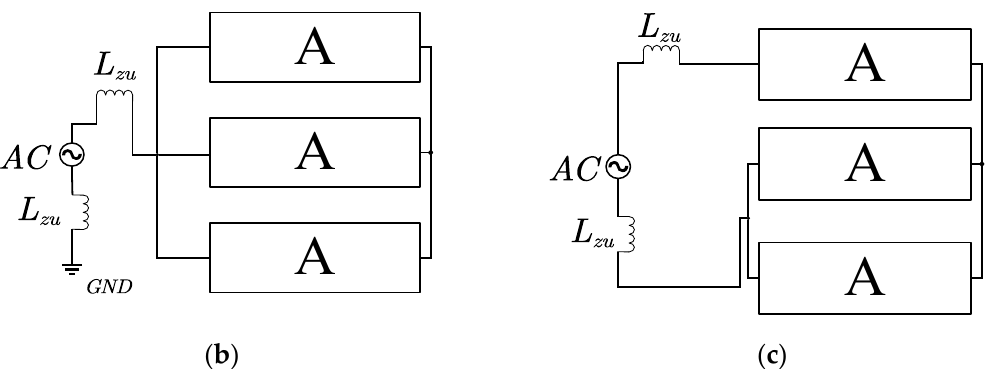
Figure 2. High-frequency lumped parameter circuit model of single-phase machine based on common mode and differential mode measurement:( a ) single-phase winding model; ( b )common mode impedance wiring diagram; and ( c ) differential mode impedance wiring diagram.